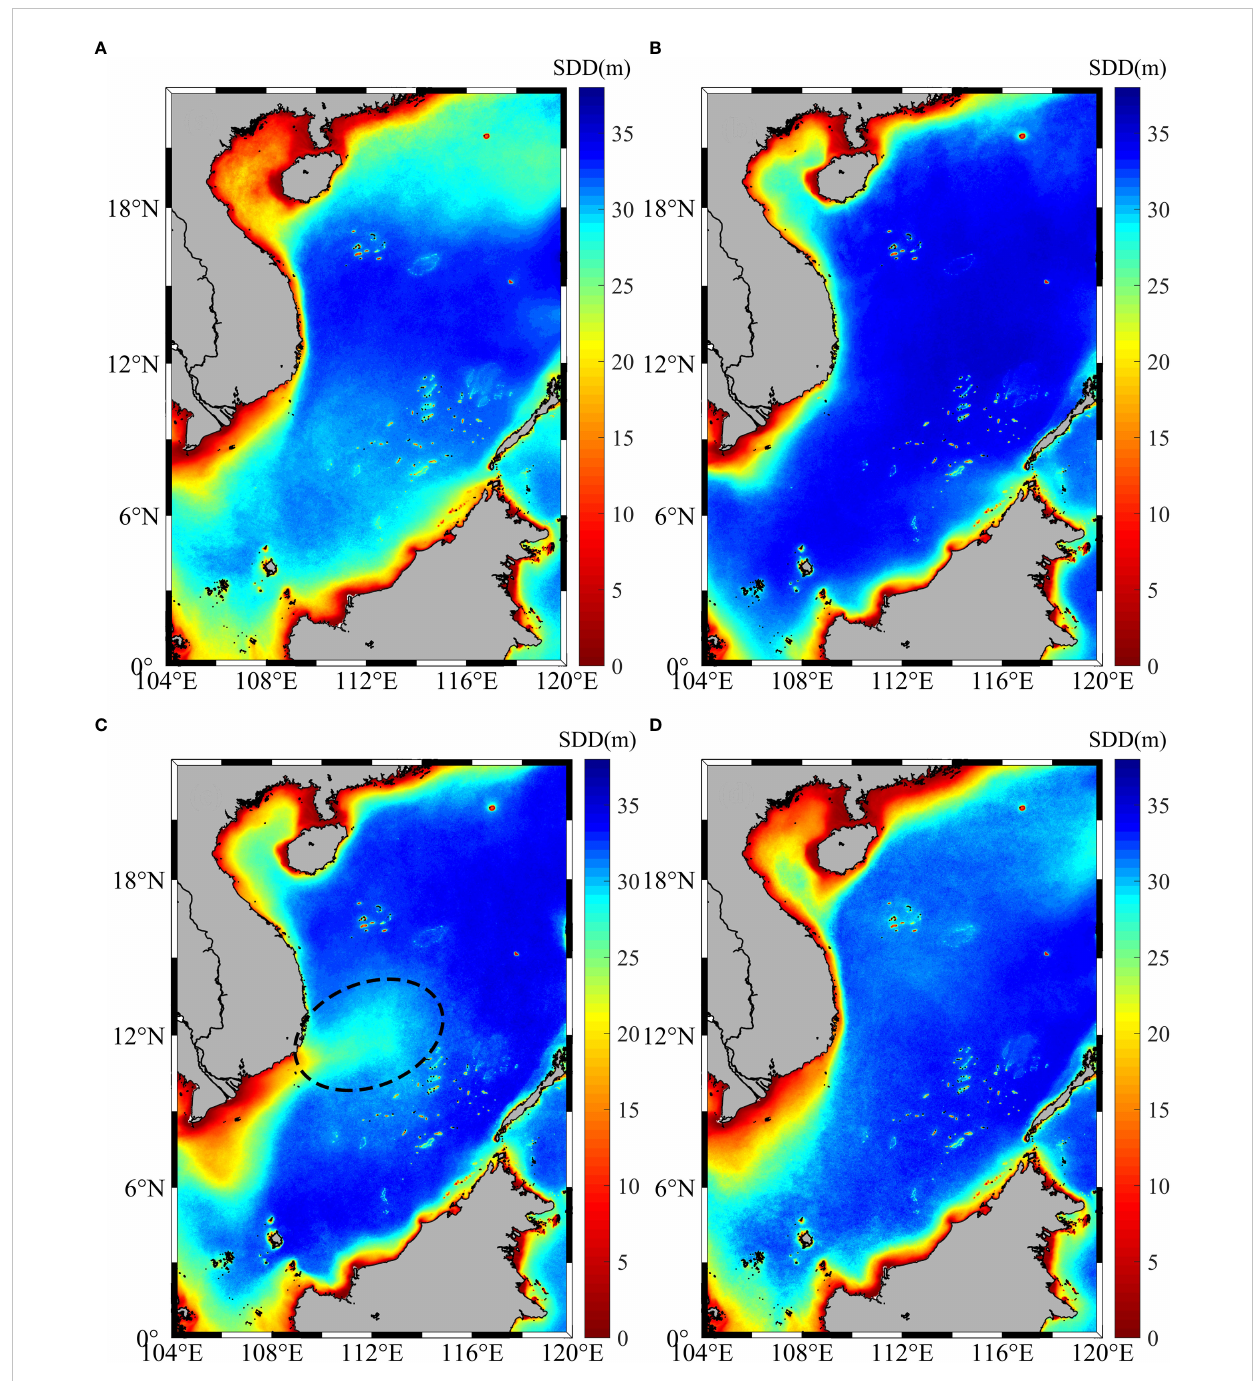
FIGURE 3 Distributions of mean SDD (background color, m) for (A) January-March (B) April-June (C) July-September (D) October-December from 2011-2020. The dotted line is the low value area of